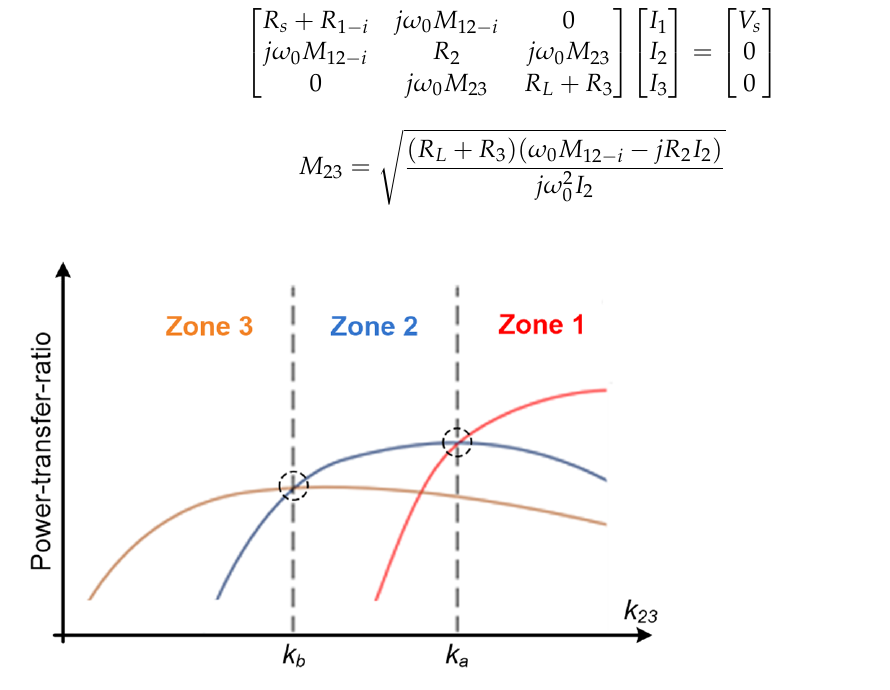
Figure 5. Illustration of selection criterion of operating zones.